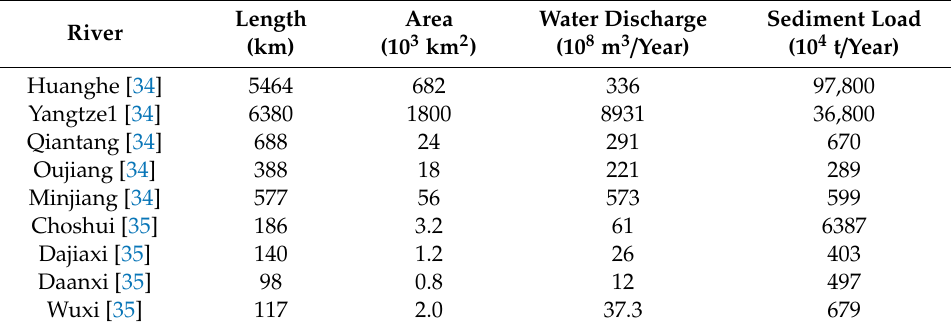
Table 1. Hydrological characteristics of major rivers along the eastern coast of